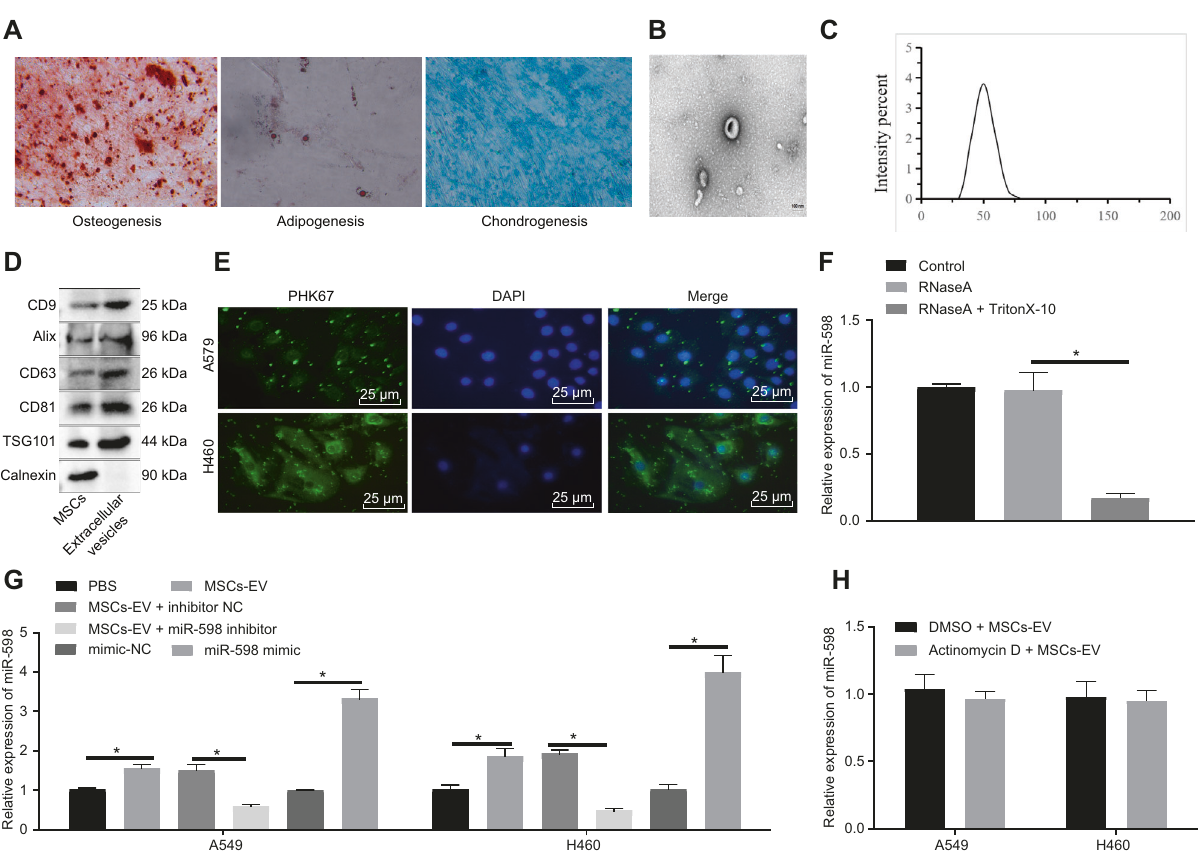
Fig. 2 Characterization of MSCs and MSCs-EVs and uptake of MSCs-EVs by NSCLC cells. A Identi fi cation of the osteogenic differentiation by Alizarin red S staininge, adipogenic differentiation by Oil red O staining, and chondrogenic differentiation by Alcian Blue staining. B Morphology of MSCs-EVs observed by TEM. C Size distribution of MSCs-EVs measure by DLS. D Speci fi c surface marker proteins of MSCs-EVs detected by Western blot analysis. E Uptake and internalization of PKH67-labeled MSCs-EVs by the cytoplasm of A549 and H460 cells observed under fl uorescence microscope. F Expression of miR-598 in A549 and H460 cells after treatment with RNase A and Triton X-100 by RT-qPCR. G Expression of miR-598 in A549 and H460 cells after different treatments by RT-qPCR. H Expression of miR-598 in A549 and H460 cells treated with MSCs-EVs after actinomycin D treatment by RT-qPCR. * p < 0.05 between two groups. Data between two groups were compared by an unpaired t test. Da t a among multiple groups were compared by ANOVA with Tukey ’ s post hoc test. Cell experiments were repeated three synsthesis inhibitor actinomycin D. As shown in Fig. 2H, there was no signi fi cant difference between the miR-598 expression in actinomycin D-treated cells and untreated cells, indicating that the miR-598 expression is not induced endogenously. In summary, our data presented that miR-598 is highly expressed in MSCs-EVs, and could be transferred in NSCLC cells by MSCs-EVs in vitro. MSCs-EVs transfer miR-598 to inhibit the proliferation, migration, and invasion capabilities of NSCLC cells in vitro Studies have shown that miR-598 can inhibit the proliferation and migration capabilities of NSCLC cells [13]. To verify the effects of EVs-derived miR-598 on the biological characteristics of NSCLC cells, we treated A549 and H460 cells with MSCs-EVs, MSCs-EVs + inhibitor NC, or MSCs-EVs + miR-598 inhibitor, with sham-treated cells as a control. CCK-8 and Transwell experiments results indicated that the proliferative, migrated, and invasive capabil-